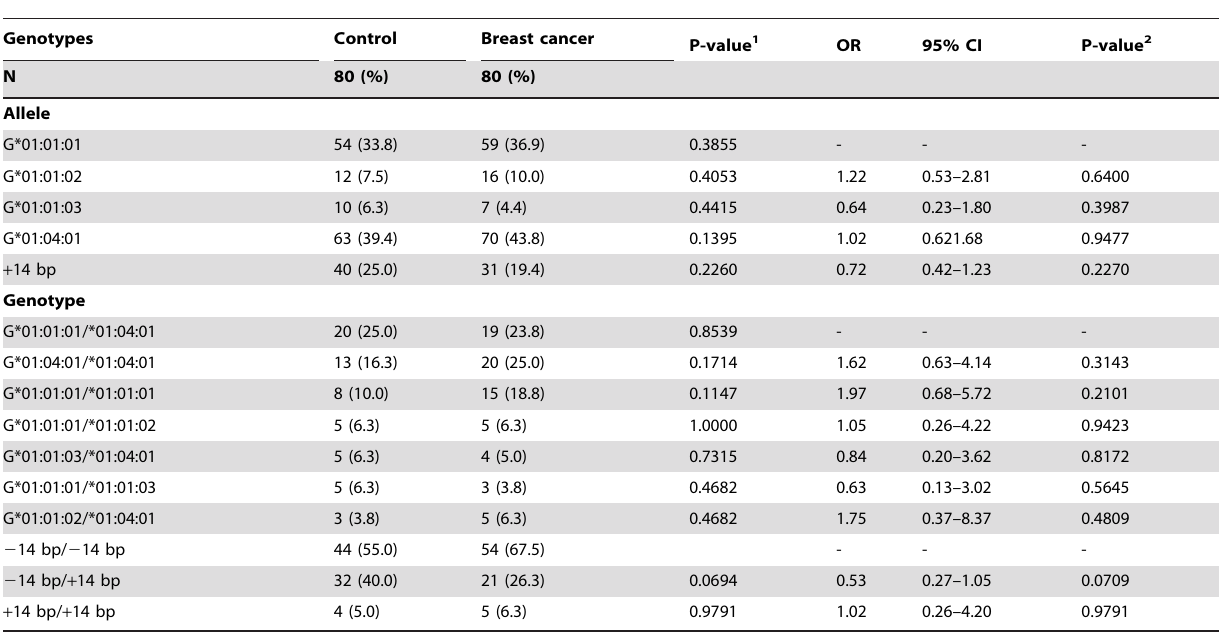
Table 1. Frequencies and odds ratios of HLA-G genotypes in breast cancer patients and control subjects.